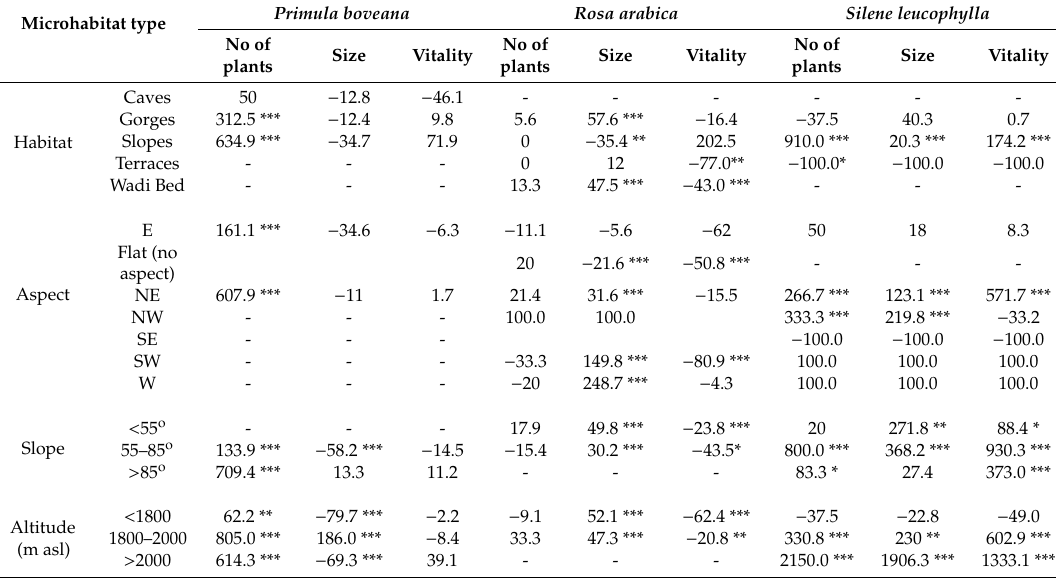
Table 5. Relative change over seven years (2007—2014) in number of plants, sizes, and plant vitality in three endemic species growing in di ff erent habitats and topographic features of the Saint Katherine Protectorate